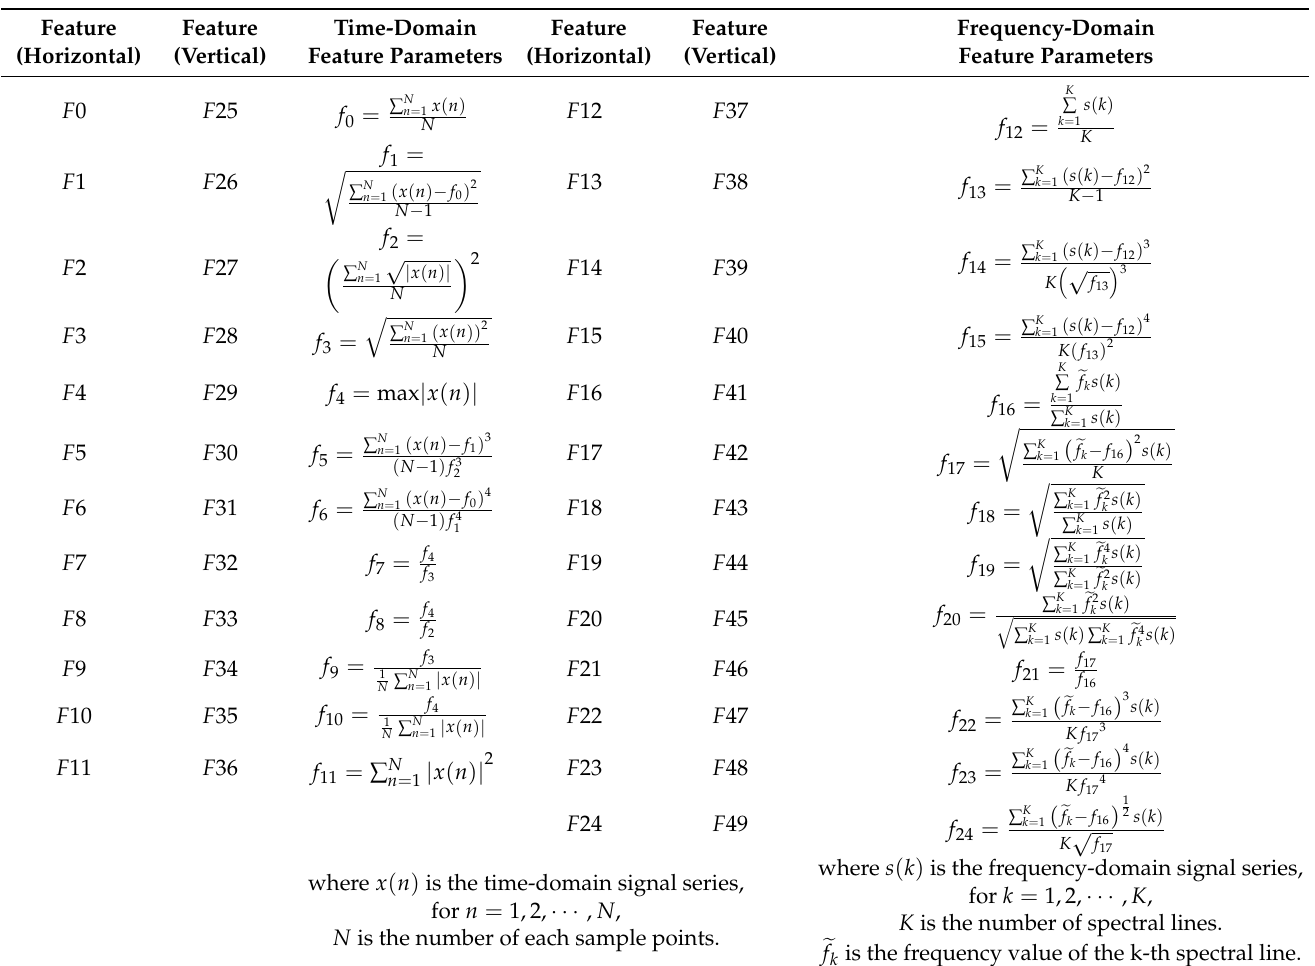
Table 2. The feature